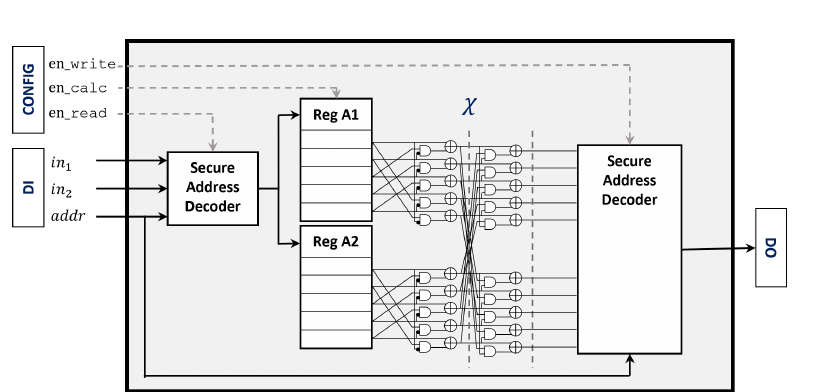
Figure 8: Masked Chi accelerator. Dashed lines illustrate register stages and control